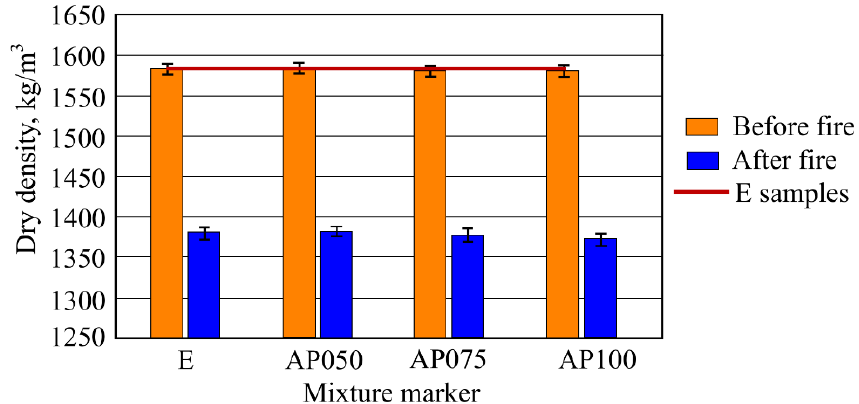
Figure 4. Results of dry density (before and after fire effect) of the samples. The results of ultrasonic pulse velocity measurements are shown in Figure 5. It can be seen that increasing the amount of CF in the samples insignificantly increases the ultrasonic pulse velocity. The highest increase was determined in the AP100 samples. Ultrasonic pulse velocity was determined to be 3364 m/s when compared to sample E (3288 m/s), which comprises 2.3%. Increase in the percentage of the ultrasonic pulse velocity in the other samples was even lower, compared with the E samples. Such an insignificant effect on sample E can mean that CF does not have a high influence on the ultrasonicpulse velocity. The tendency of the results of ultrasonic pulse velocity in the samples after fire effect was different compared to the samples before fire effect. When compared with sample results which were obtained from the fire temperature effect, in this case the determined difference was lower. The determined ultrasonic pulse velocity in AP100 sample was 3063 m/s and that was 1.7% lower than in sample E. Determined ultrasonic pulse velocity in samples AP050 and AP075 was lower than that of sample E.